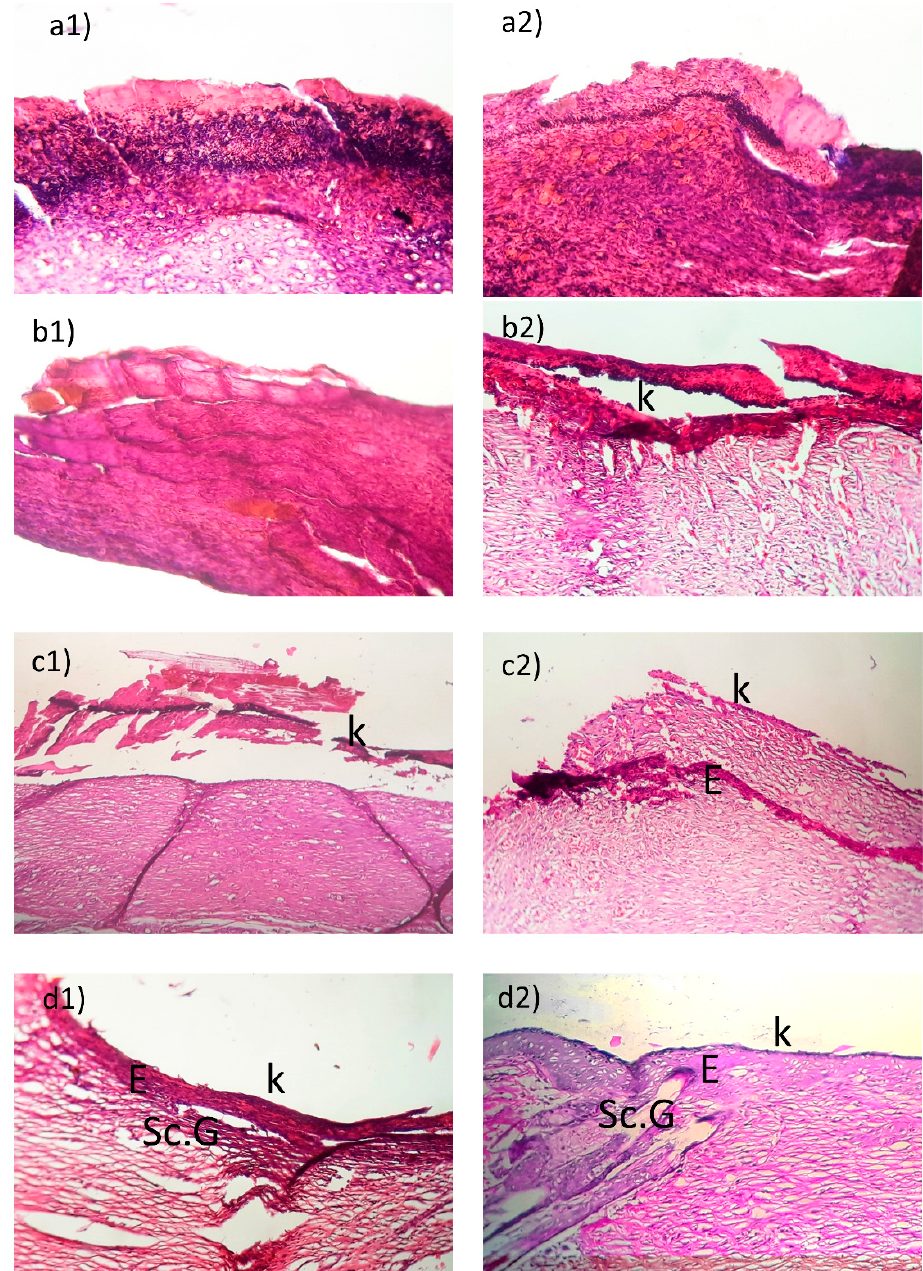
Figure 7. Histological changes during the wound-healing process. Histology of the wound tissue of experimental groups, ( a1 , a2 ) NS treatment, ( b1 , b2 ) PTX solution, ( c1 , c2 ) LC sponge and ( d1 , d2 ) LC sponge containing LCNs/PTX. N.F, follicles; Sc. G, sebaceous glands; K, keratin layer; E, epidermis layer.